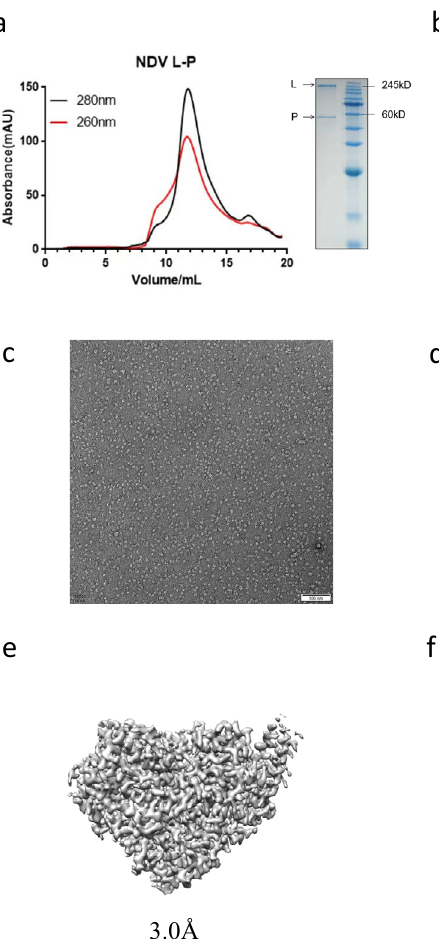
representativecryo-EMmicrographofNDVL-Pcomplex(outof7134micrographs). e The fi nal cryo-EM density map of NDV L c -P complex. f The fi nal cryo-EM density map of NDV L f -P complex. Source data are provided as a Source Data fi le. Sample preparation-related experiments including protein puri fi cation and enzymatic assays were reproduced at least three times